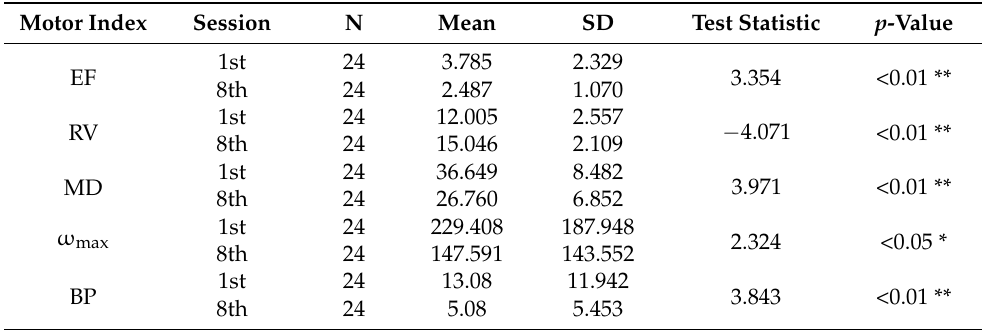
Table 10. Summary statistics and paired t -test for comparing motor indecies between the first and eighth training for the the Ship Driving VR